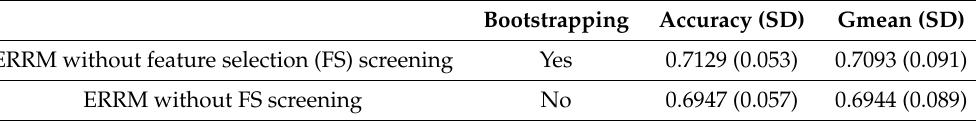
Table 3. Comparison of proposed ERRM with and without bootstrapping.